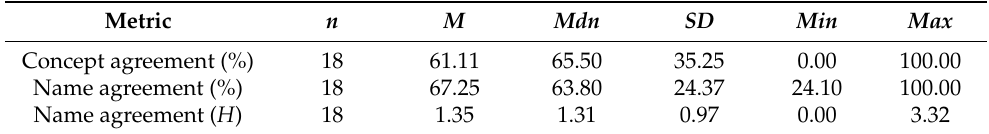
Table 4. Descriptive statistics for the agreement metrics across all 18